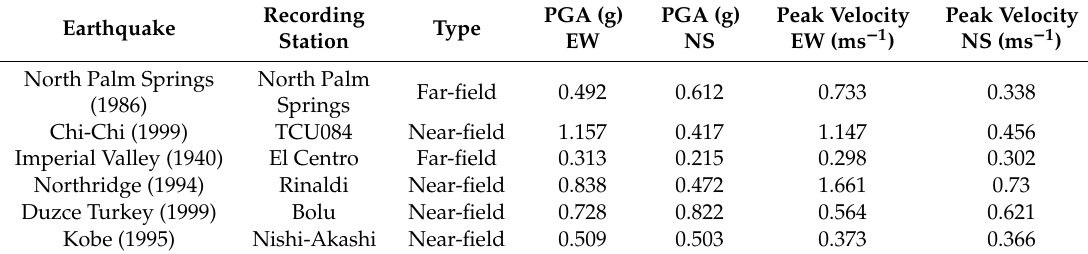
Figure 3. Passive Simulink model of the benchmark bridge [26]. Table 1. Properties of earthquake records.